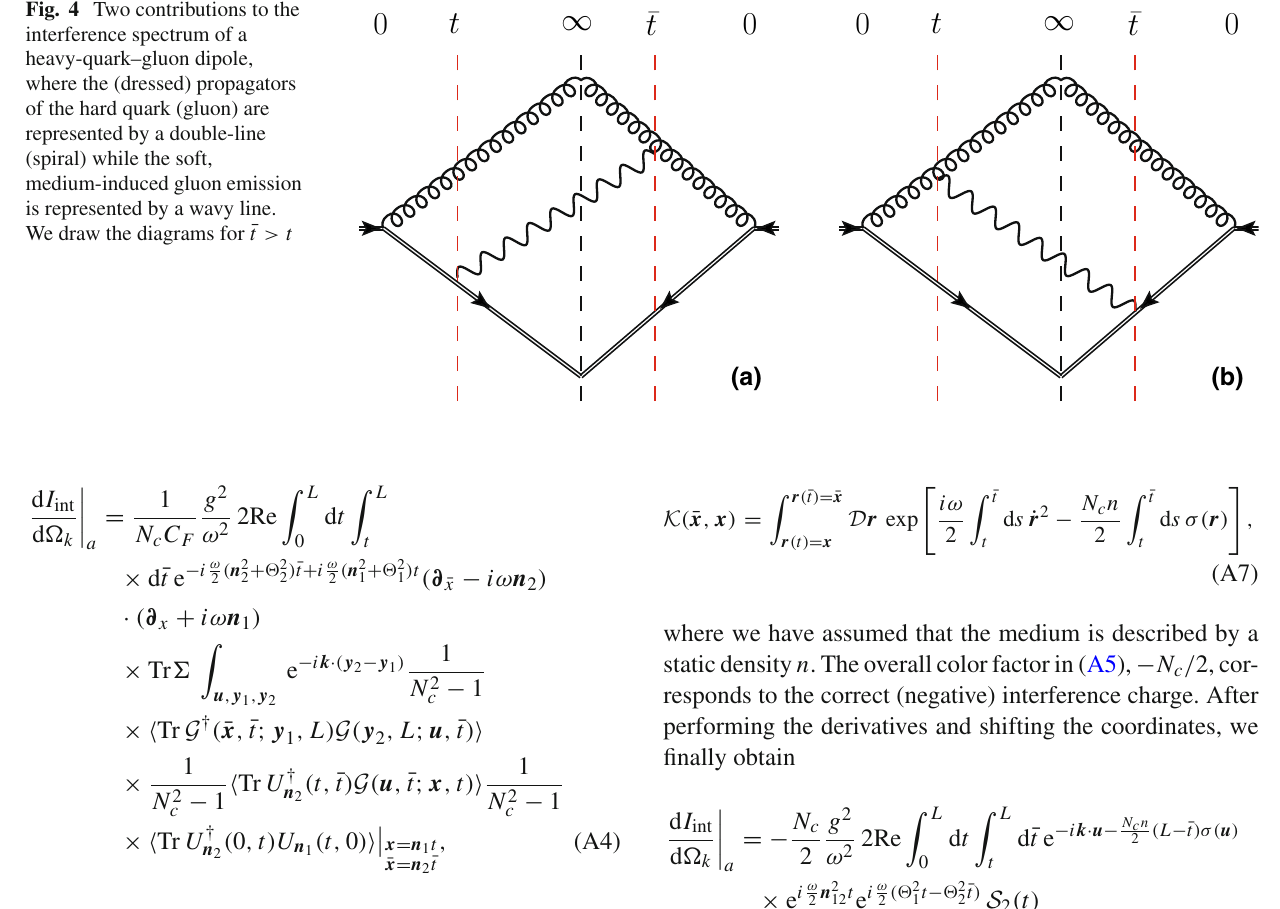
Fig. 4 Two contributions to the interference spectrum of